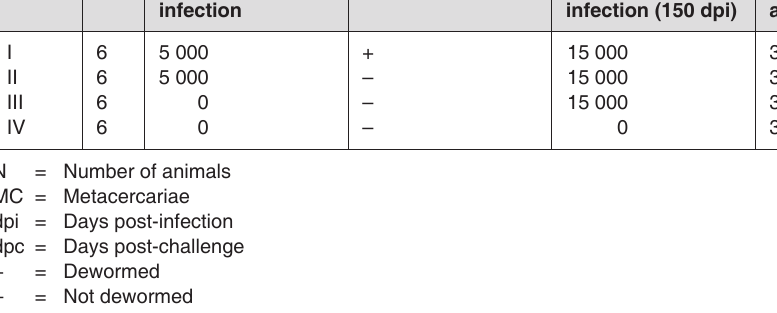
TABLE 1 Summary of the study design and experimental procedures